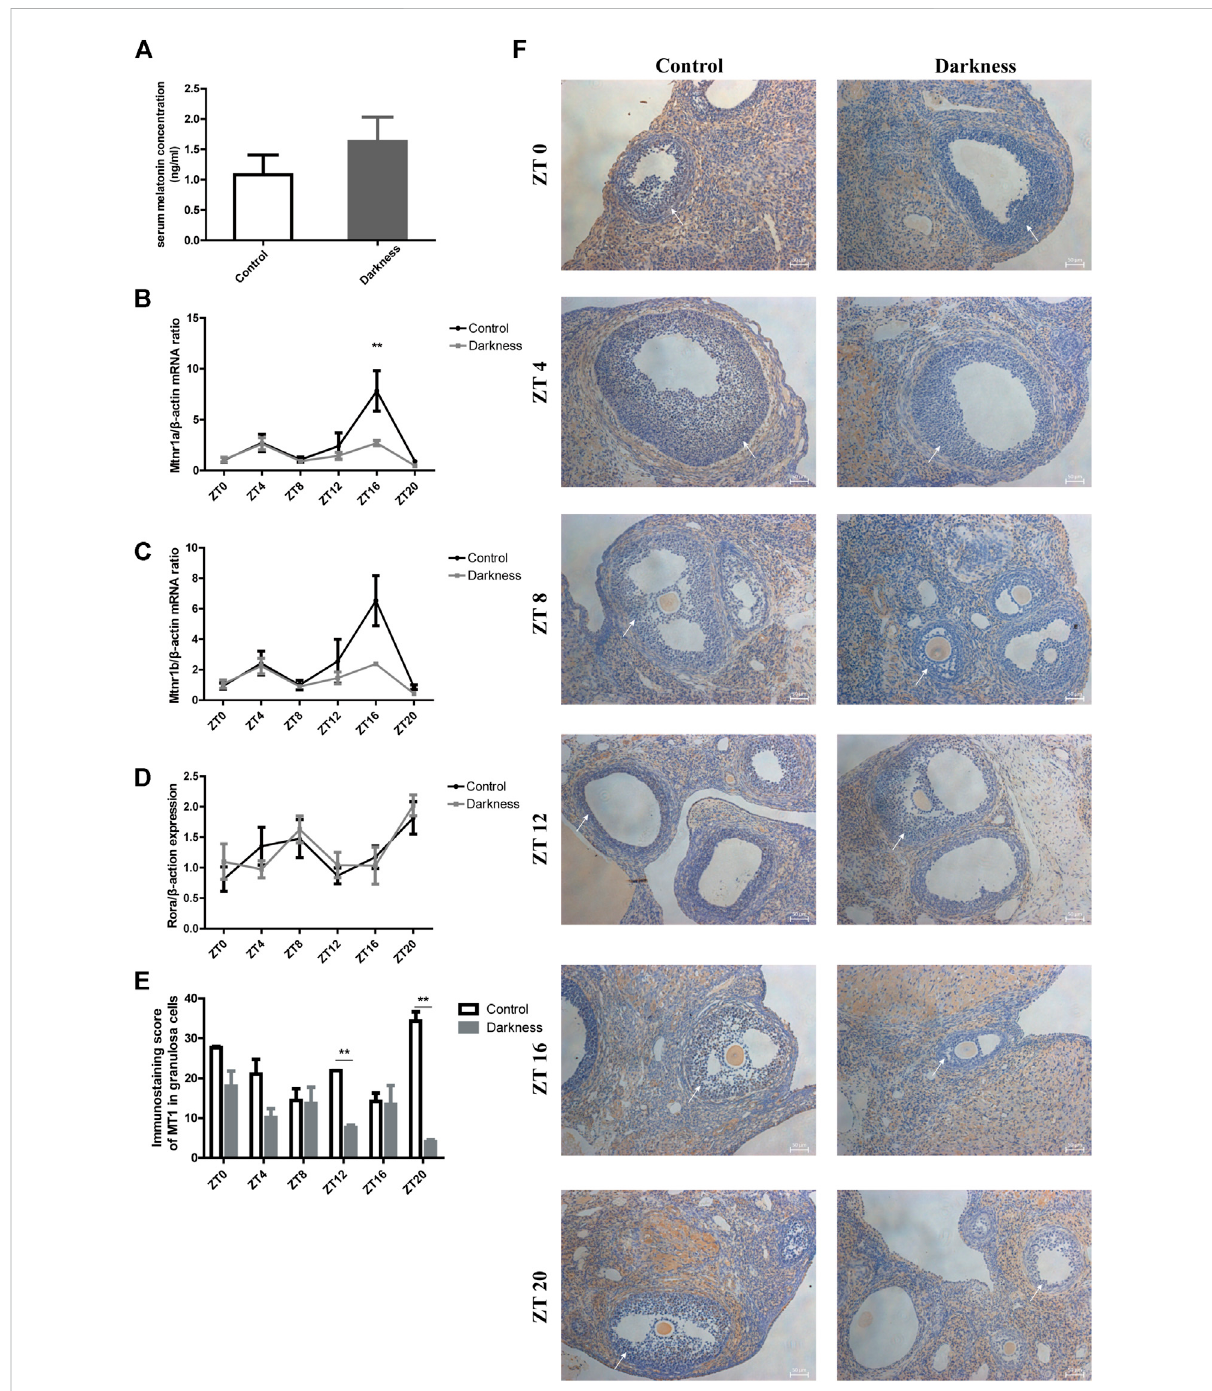
FIGURE 4 Melatoninlevelinserumanditsreceptorexpressioninratovaries. (A) SerumlevelofmelatoninatZT16. (B) RelativemRNAabundanceof Mtnr1a inratovaries. (C) RelativemRNAabundanceof Mtnr1b inratovaries. (D) RelativemRNAabundanceof Rora inratovaries. (E) Immunostainingscoreof MT1 in ovarian GCs of rats. (F) Representative photomicrographs of MT1 in follicular GCs. Scale bar: 50 μ m. N = 5/group. Values are expressed as means ± SEM. Signi fi cant differences between the two groups are indicated by asterisks (* p < 0.05 and ** p <